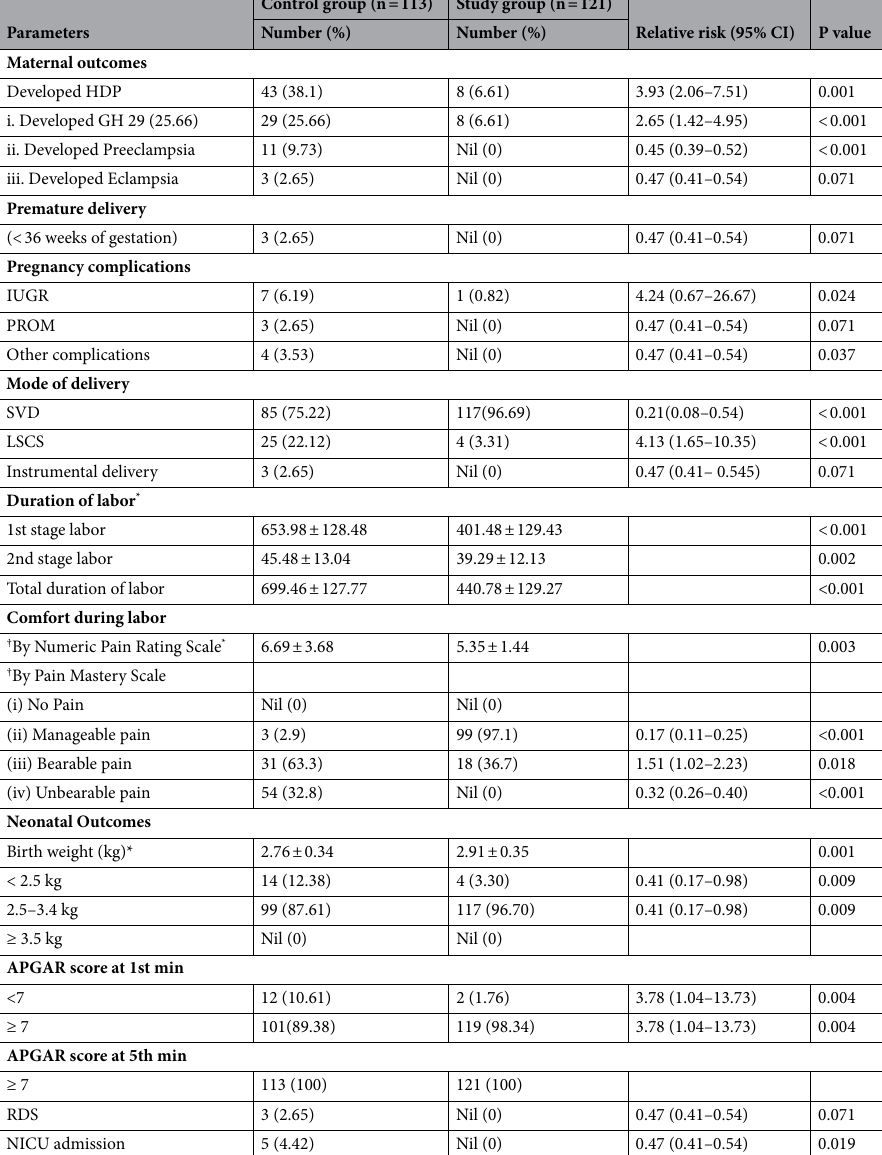
Table 3. Comparison of maternal and neonatal outcomes, and assessment of relative risks (RR) in women with risk of developing gestational hypertension in Control group and Study group in the perinatal period. The data are presented as number and percentage. * The duration of labor, assessment of comfort during labor by NPRS (Numeric Pain Rating Scale), and birth weight are expressed in Mean ± SD and comparison of these continuous data was done by independent t test. P value < 0.05 was considered statistically significant. HDP hypertensive disorders of pregnancy, GH gestational hypertension, IUGR intrauterine growth retardation, PROM premature rupture of membrane, SVD spontaneous vaginal delivery, LSCS lower segment caesarean section, APGAR appearance, pulse rate, grimace, activity and respiration, RDS respiratory distress syndrome, NICU neonatal intensive care unit. † Numeric pain rating scale ranges from 0 to 10. The scale 0 represents “no pain”, 1 to 3 represents “mild pain”, 4 to 6 represents “moderate pain” and 7 to 10 represents “severe pain”. Pain mastery scale has 4 grading of pain: no pain, manageable pain, bearable pain and unbearable